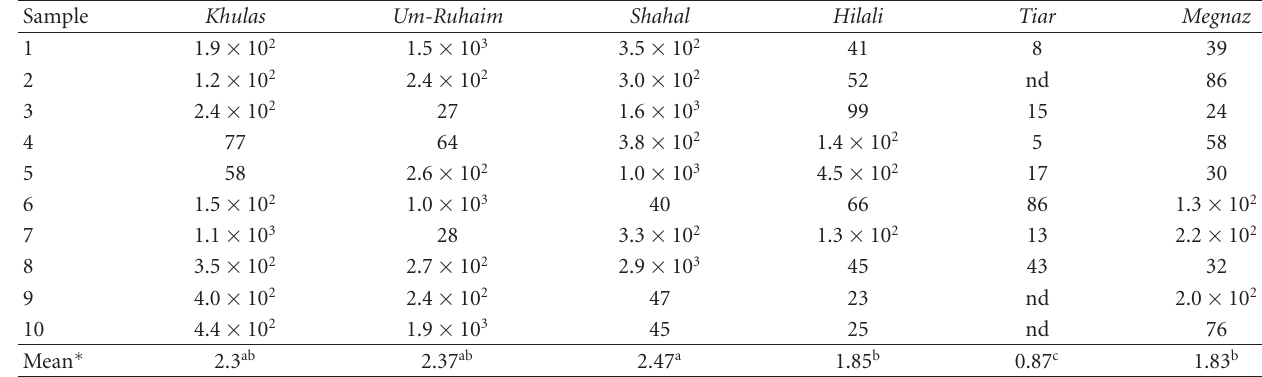
Table 3: Counts of Staphylococcus aureus contaminating rutab samples (cfu/cm 2 ).